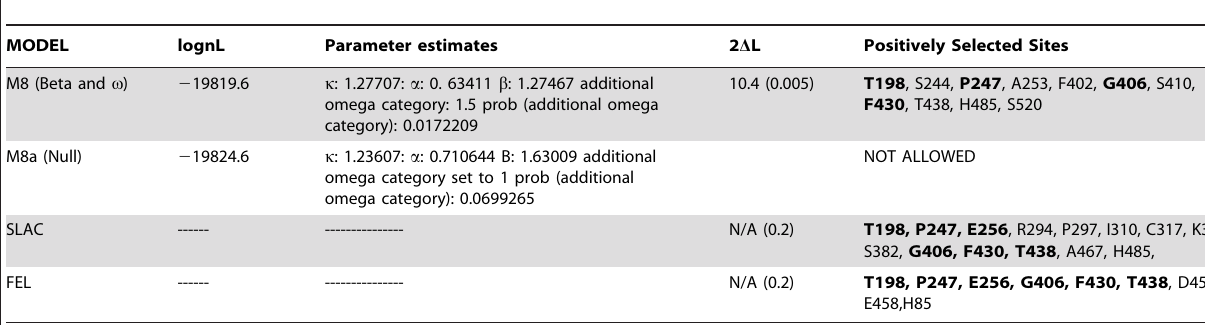
Table 1. Selection analyses of DDX3X using maximum likelihood approach.